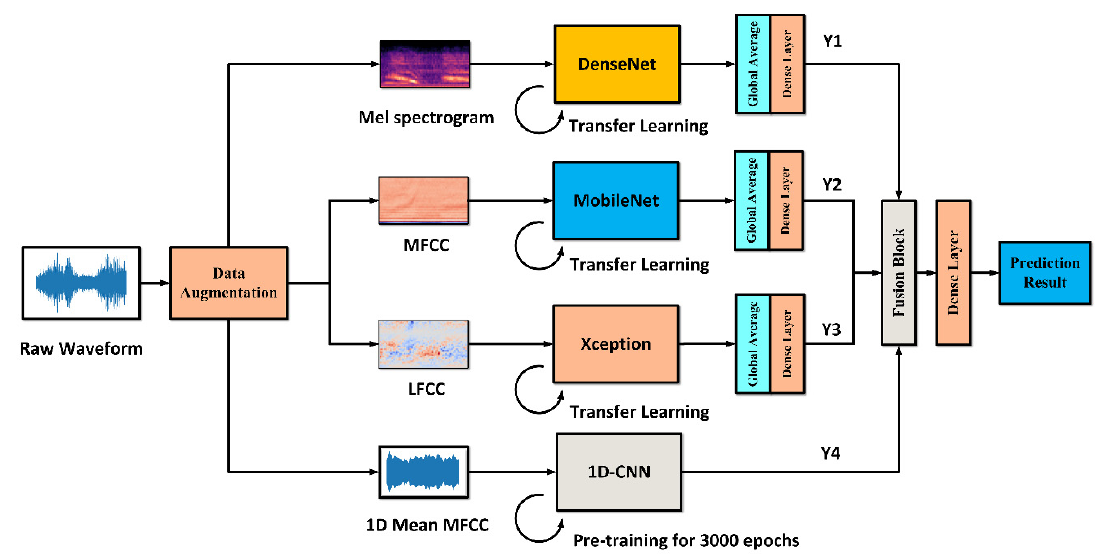
Figure 4. The network structure of MDF-PNet.